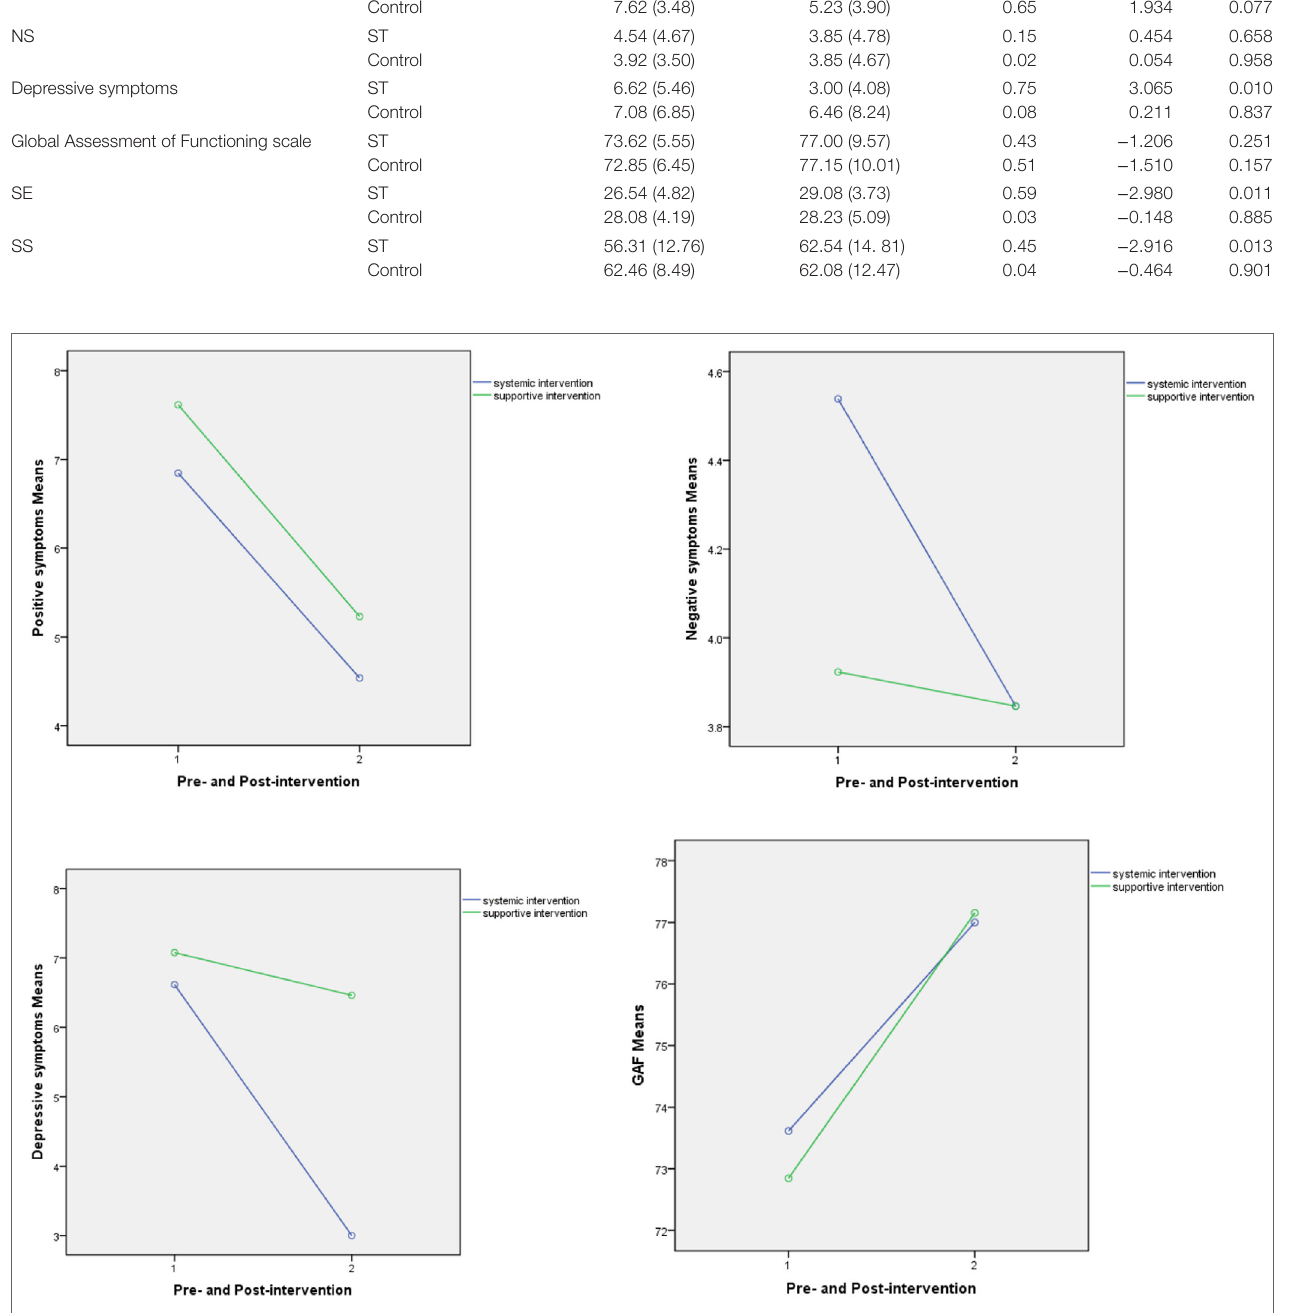
FigUre 1 | Improvements in scores of severity of